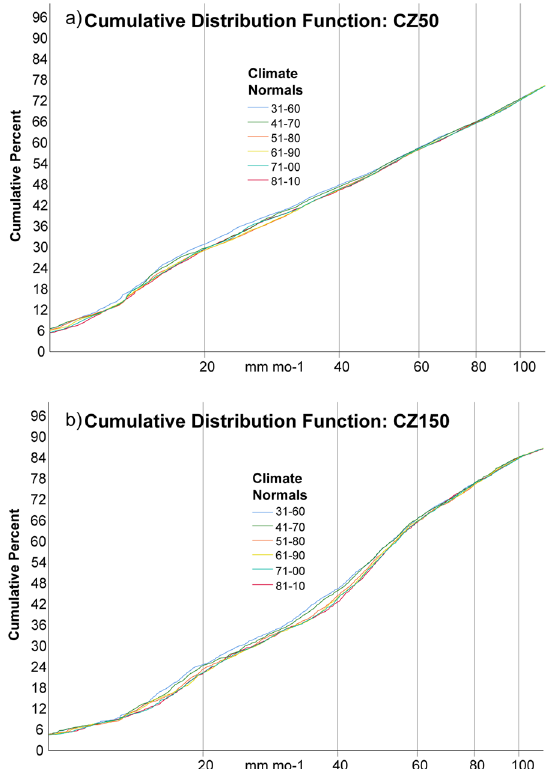
Figure 6. Cumulative distribution functions for ( a ) CZ50 and ( b ) CZ150 of thirty-year precipitation averages (mm mo − 1 ) with a 10-year sliding window from 1931–1960 to 1981–2010 (see